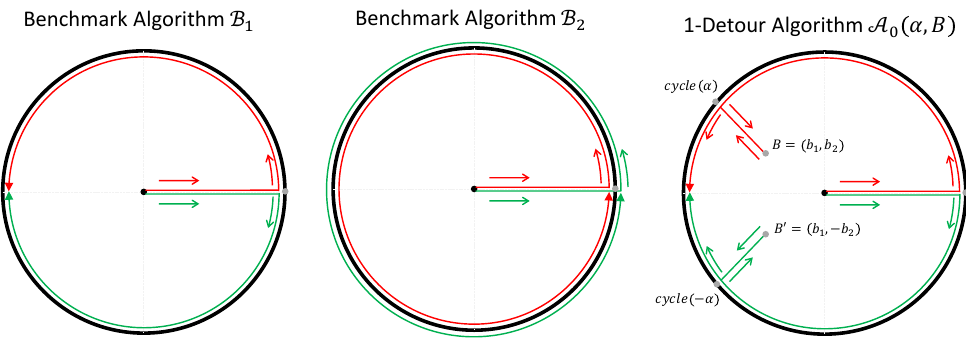
Figure 3. Robot Trajectories for algorithms B 1 , B 2 , A 0 . The depicted trajectories show the search of the circle, and not the evacuation step that is performed once the exit is